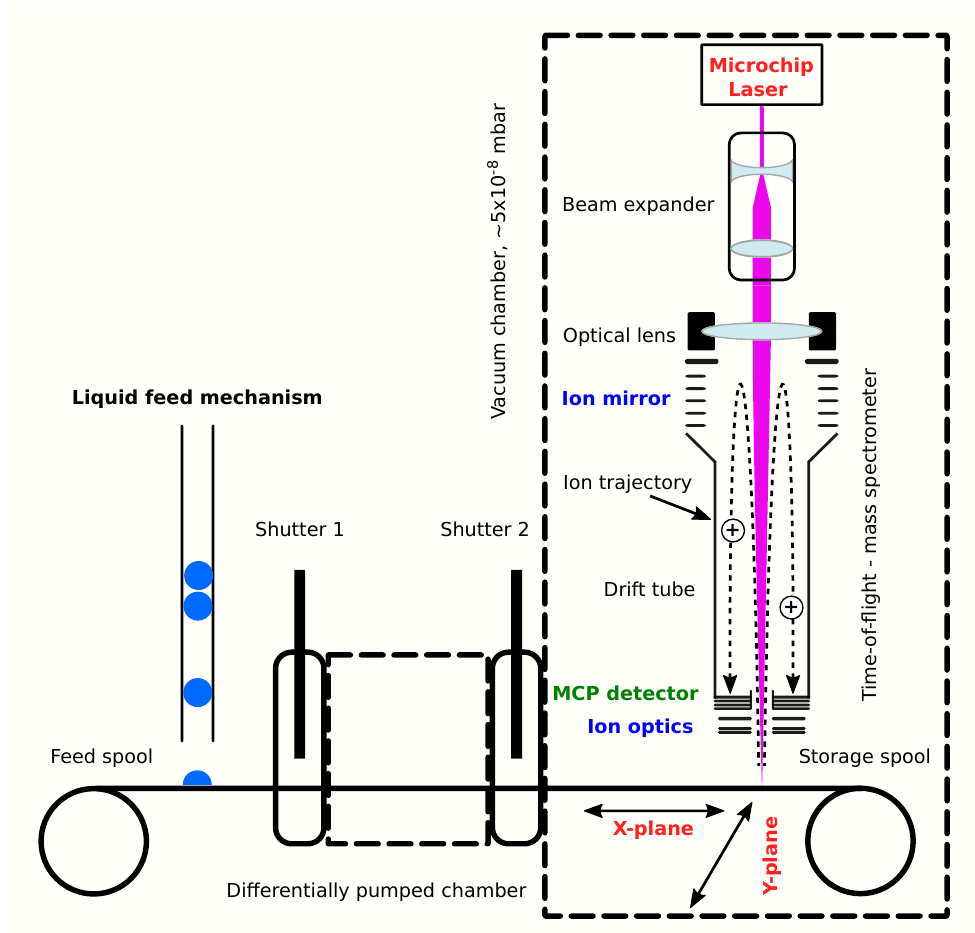
Figure 6. Schematic depiction of an ORIGIN-VLF flight instrument with a differentially pumped sample feedthrough mechanism. The mass analyser and microchip laser are housed in a vacuum chamber. A conveyor-belt sample introduction system transfers sample material from